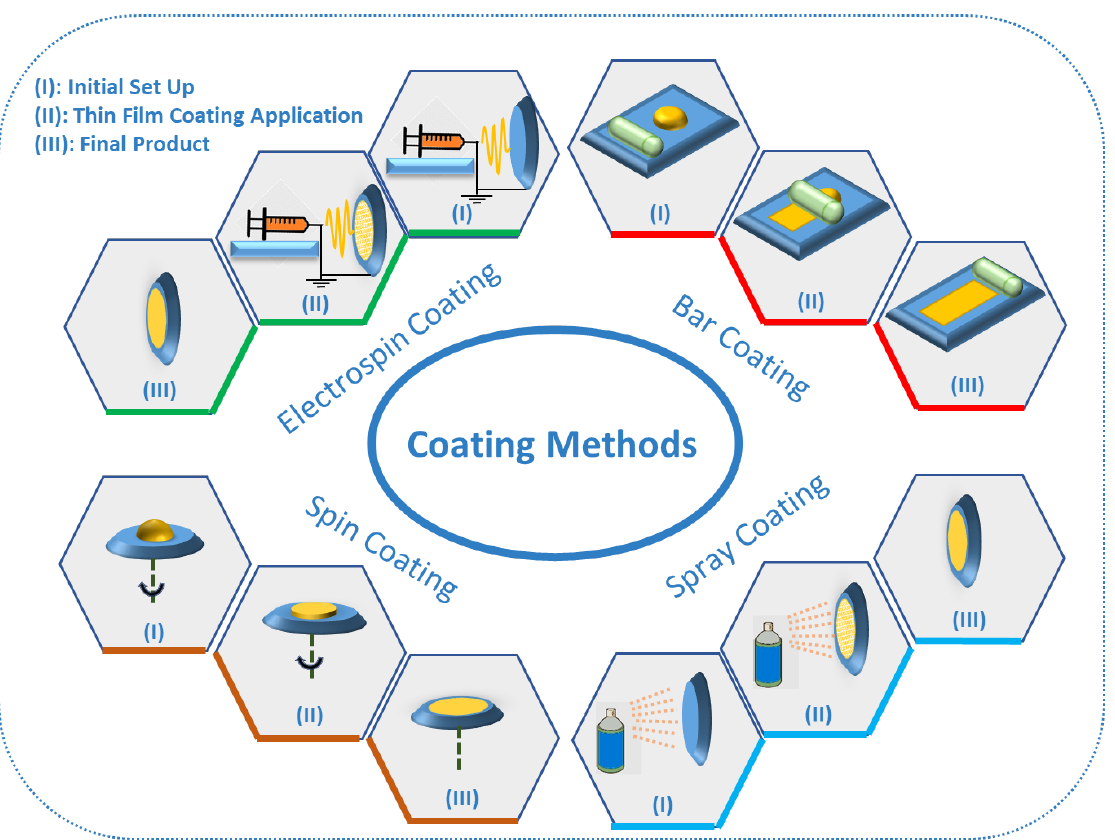
Figure 4. The different coating methods for preparation of TF-SPME devices. Figure 4. The di ff erent coating methods for preparation of TF-SPME